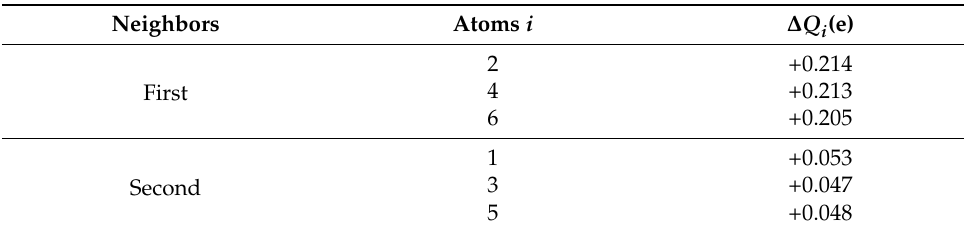
Table 3. Changes in the Bader charge at the T–MnO 2 /graphene-V O interface.